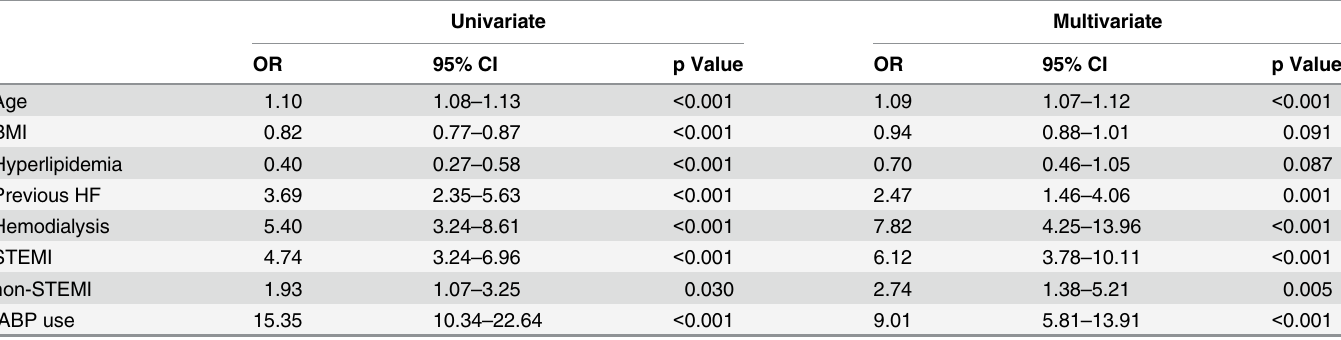
Table 8. Multivariate Logistic Regression Analysis on In-hospital Mortality in Patients without Cardiogenic